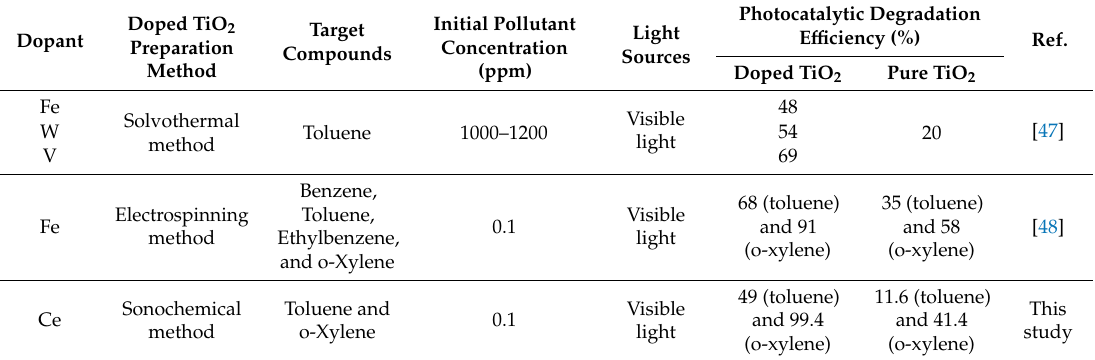
Table 3. Comparison of the photodegradation e ffi ciencies of VOCs (volatile organic compounds) with literature